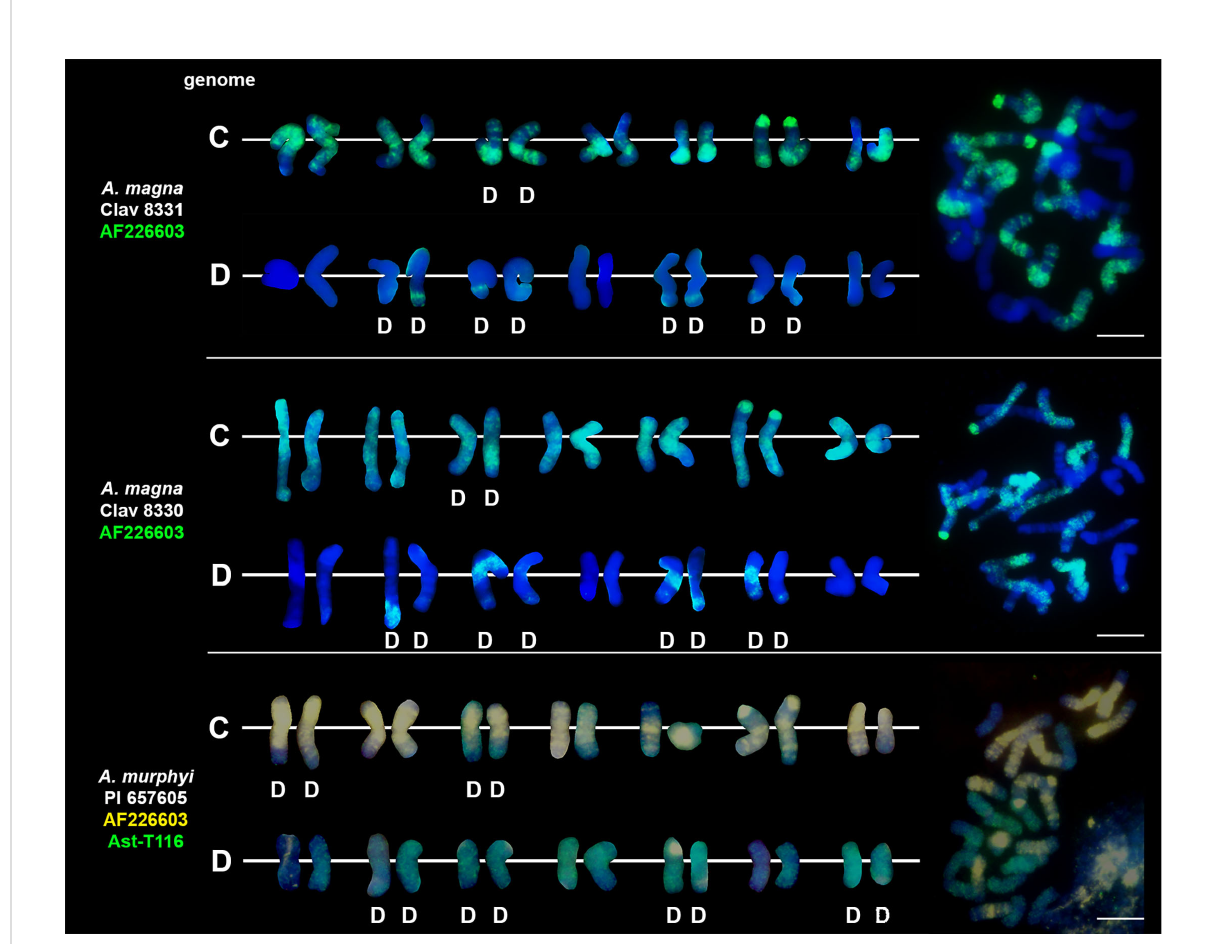
FIGURE 3 Genome composition and intergenomic translocations pattern in tetraploid oat species belonging to CCDD Avena group. D- distal translocation. Scale bar = 10 m